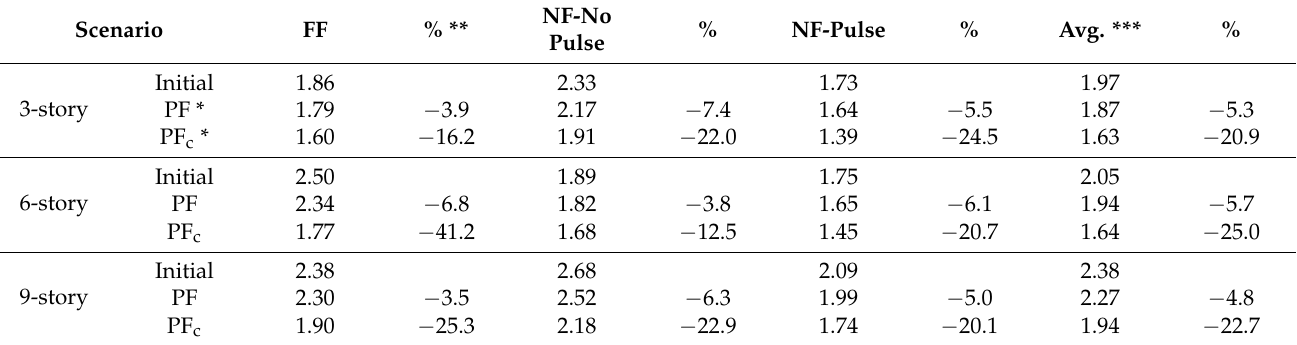
Table 6. Comparison of